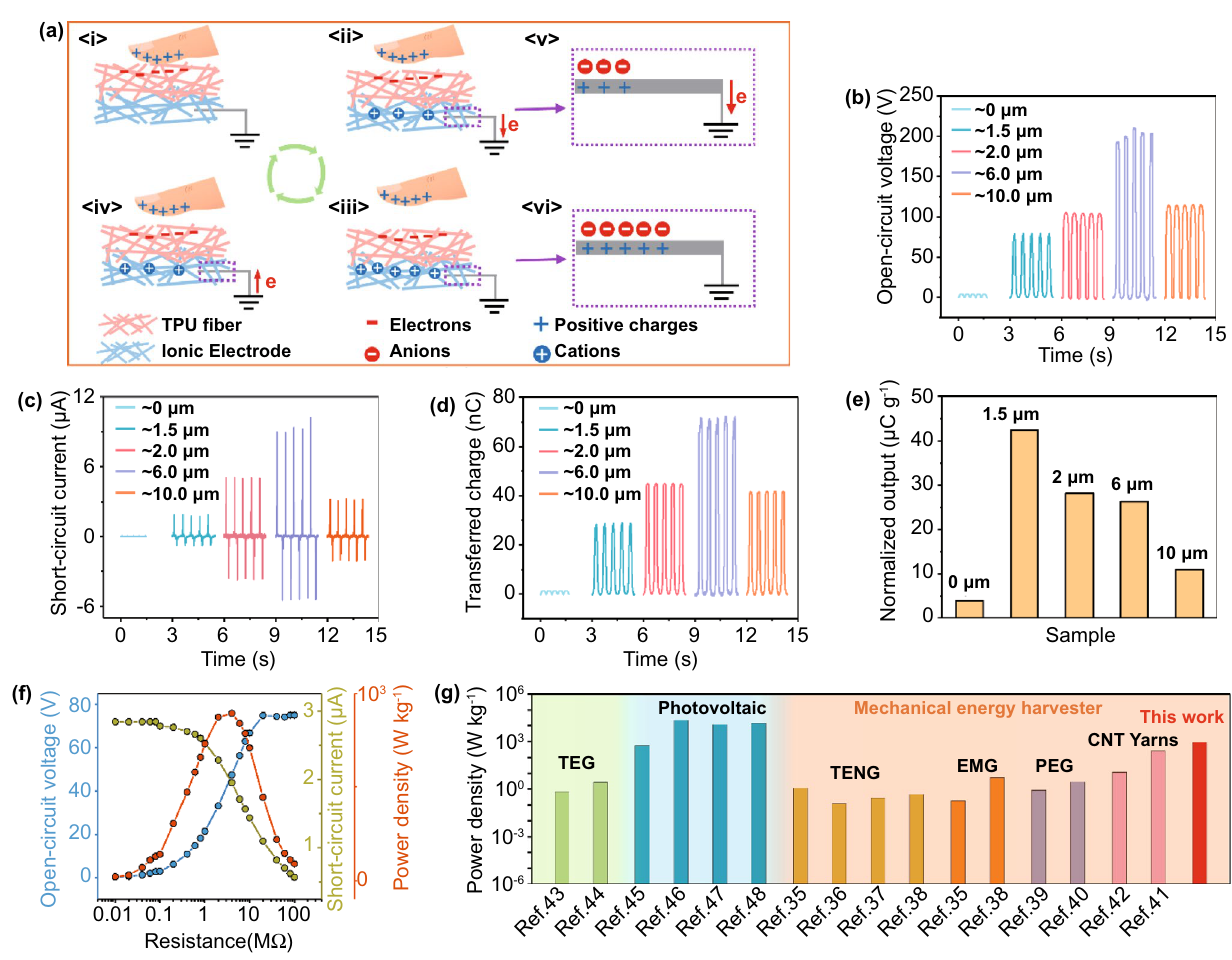
Fig. 3 The operation principles and output performance of the ITM. a Working mechanism of the ITM when contacts with human finger; b – e with ionic electrode layer fixed at 1 μm, the open-circuit voltage, short-circuit current, transferred charges and normalized output of the ITM when increasing the thickness of TPU layer; f with the ionic electrode layer of 1 μm and the TPU layer of 1.5 μm, open-circuit voltage, short- circuit current and power curves with external resistance ranging from 0.01 to 100 MΩ; g comparison of weight specific power density between the ITM and other environmental energy technologies, including mechanical energy harvesters (TENG, EMG, PEG, and electrochemical har- vester based on CNT yarns), thermoelectric generator and photovoltaic devices. TEG thermoelectric generator, TENG triboelectric nanogenera- tor, EMG electromagnetic generator, PEG piezoelectric